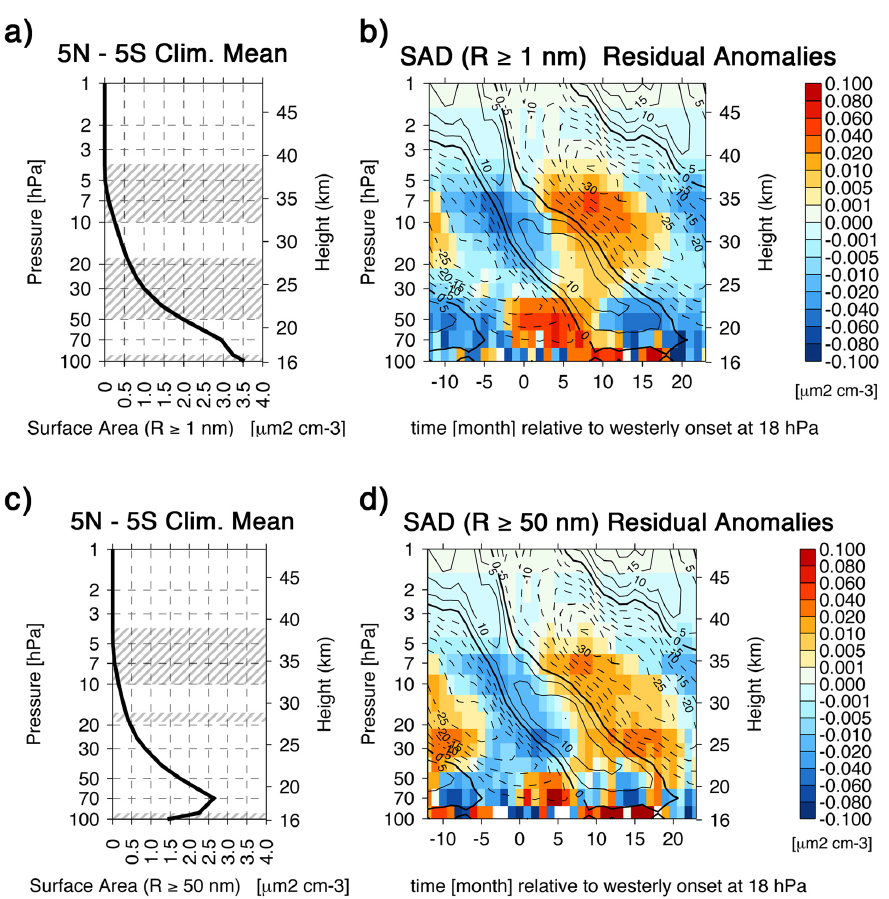
Figure 7. As in Fig. 6, except for residual anomalies in the modelled aerosol surface area density (SAD). Data in the upper panels have been inferred from the entire modelled size distribution (1 nm ≤ R < 2 . 6 µm). In the lower panels the aerosol size range has been adapted to the detectability of space-borne remote sensors (50 nm ≤ R < 2 . 6 µm).